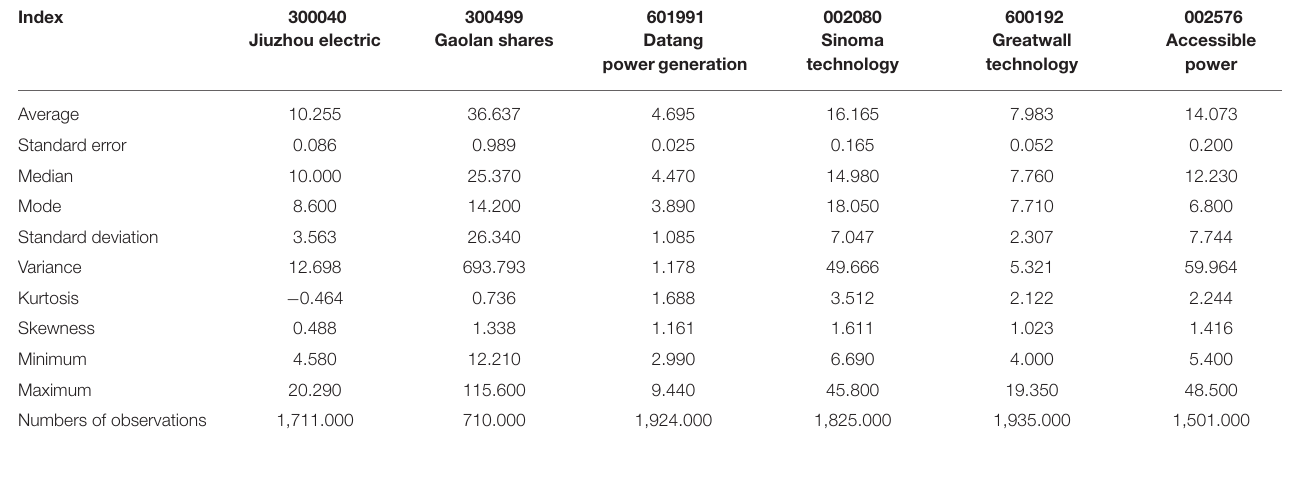
TABLE 1 | Descriptive statistics of wind power enterprise performance data.